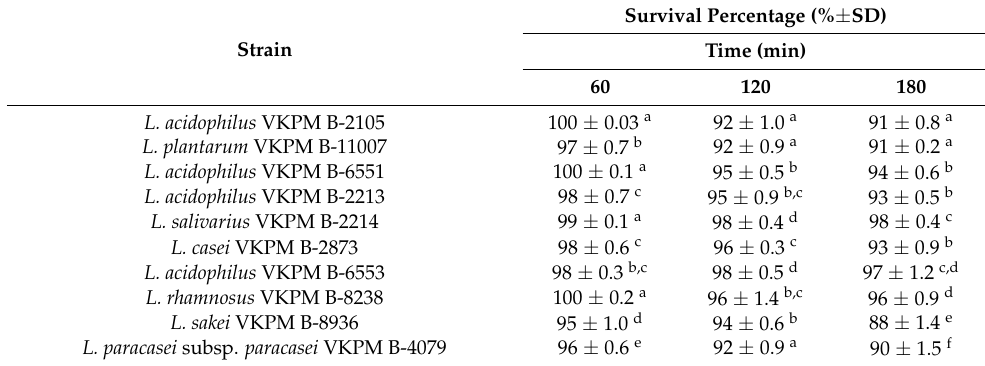
Table 7. Tolerance of Lactobacillus strains to